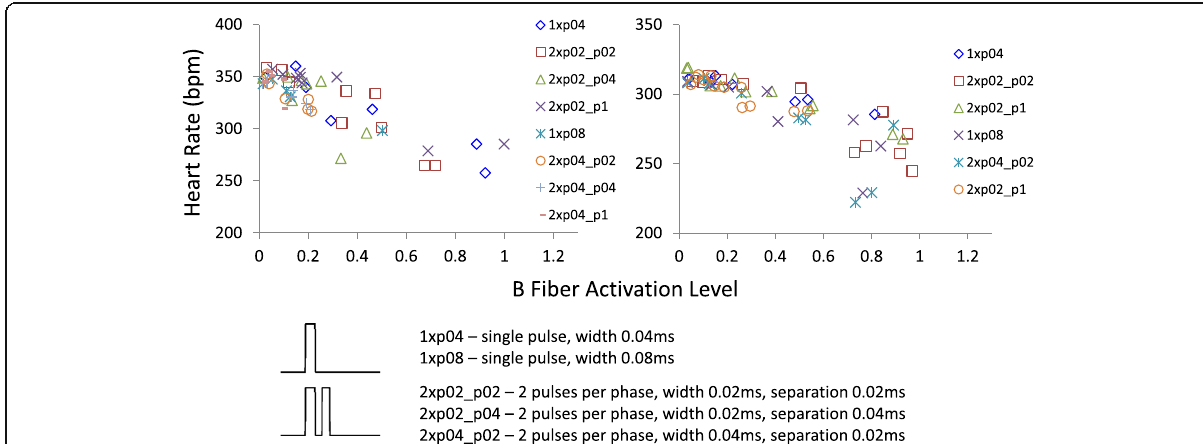
Fig. 6 B fiber-heart rate profiles with different stimulus waveforms. Raw heart rate was plotted against B fiber activation with different stimulus wave- forms denoted. Though different waveforms produced variable nerve activation patterns and variable effects on the heart rate, the B fiber and heart rate relationship appeared consistent. The two plots were from two different animals. Waveform legend is explained with example